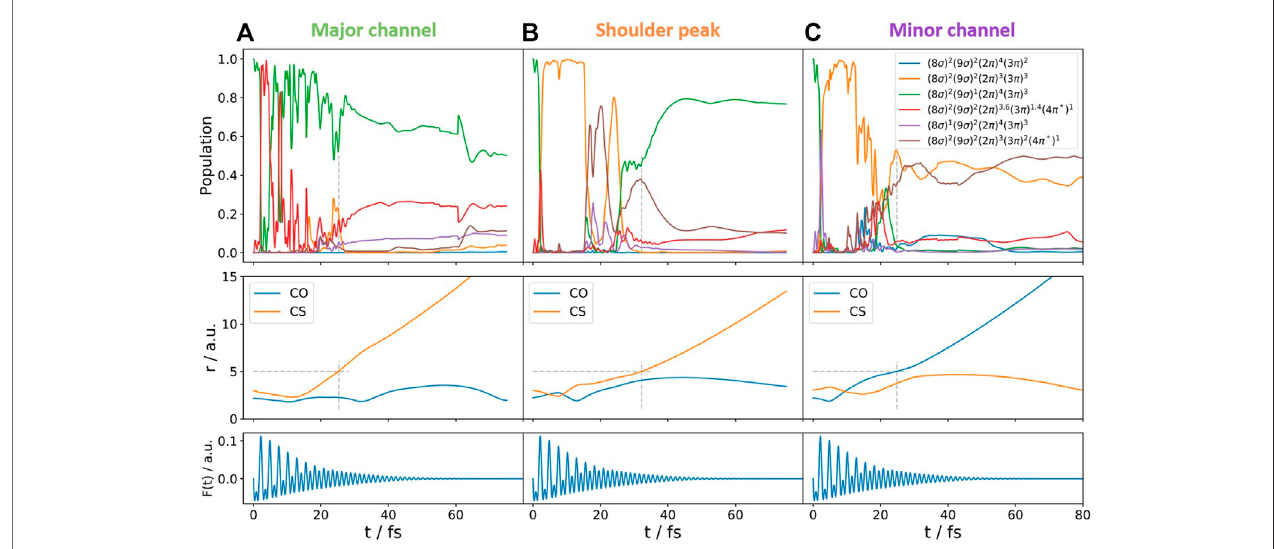
FIGURE7| Quantum amplitudes(inthelimitofin fi nitetrajectories,thiswouldcorrespondtopopulations)ofdifferentexcitedstates(top),bondlengthC-OandC-S (middle),andthetemporalshapesoftheappliedelectric fi elds(bottom)duringthedissociationofselectedtrajectories.Theserepresenttypicaltrajectoriesfollowing (A,B) theOC + +S + channeland (C) theO + +CS + channel.AKER > 5 eV (A) isassociatedwiththemainpeakoftheOC + +S + channelintheexperiment,whileaKER < 4.5 eV (B) is attributed to the shoulder peak. The KERs at the end of these speci fi c trajectories correspond to 7.9 eV (A) , 3.9 eV (B) , and 5.8 eV (C) . Dashed gray lines indicate the time when the (arbitrarily chosen) value of r = 5 a. u. is reached. We note that such dissociation is reached at a later time for the shoulder peak compared to the main peak; another strong indication for post-ionization dynamics.